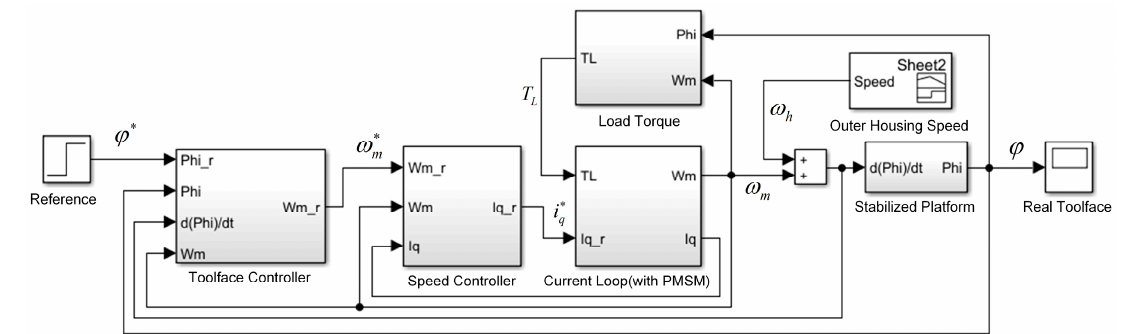
Figure 6. Simulation diagram of the toolface control method .